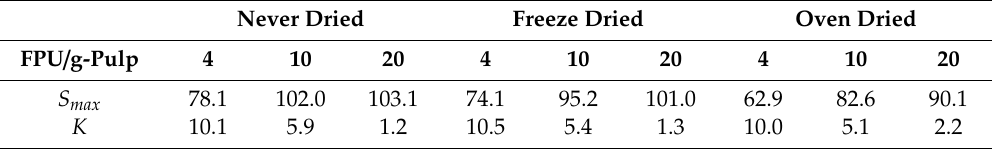
Table 2. The prediction of final enzymatic digestibility depending on enzyme dosage and drying. Never Dried Freeze Dried Oven Dried FPU / g-Pulp